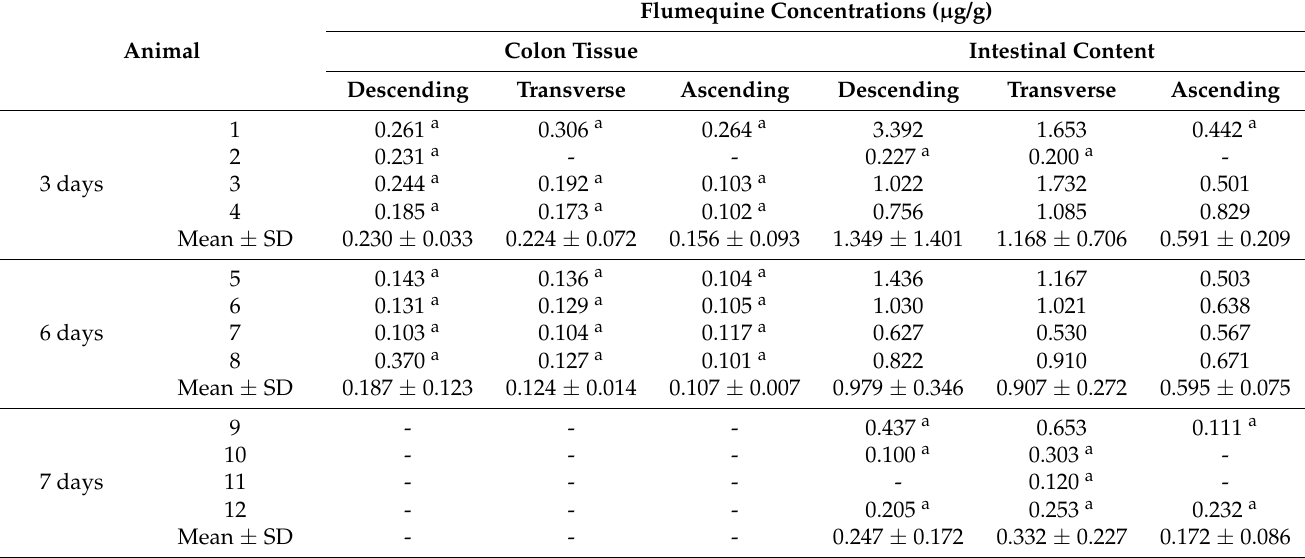
Table 3. Flumequine concentrations in colon tissue and intestinal contents in pigs after oral administration with drinking water (individual concentrations, and mean ±